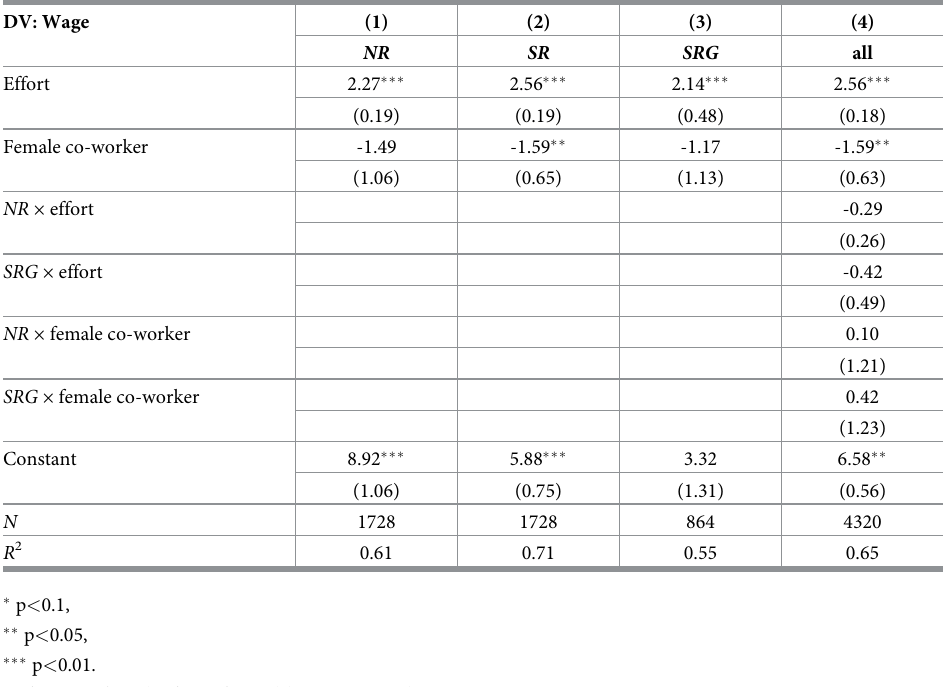
Table 4. Wage-effort regressions by co-worker gender (employer fixed